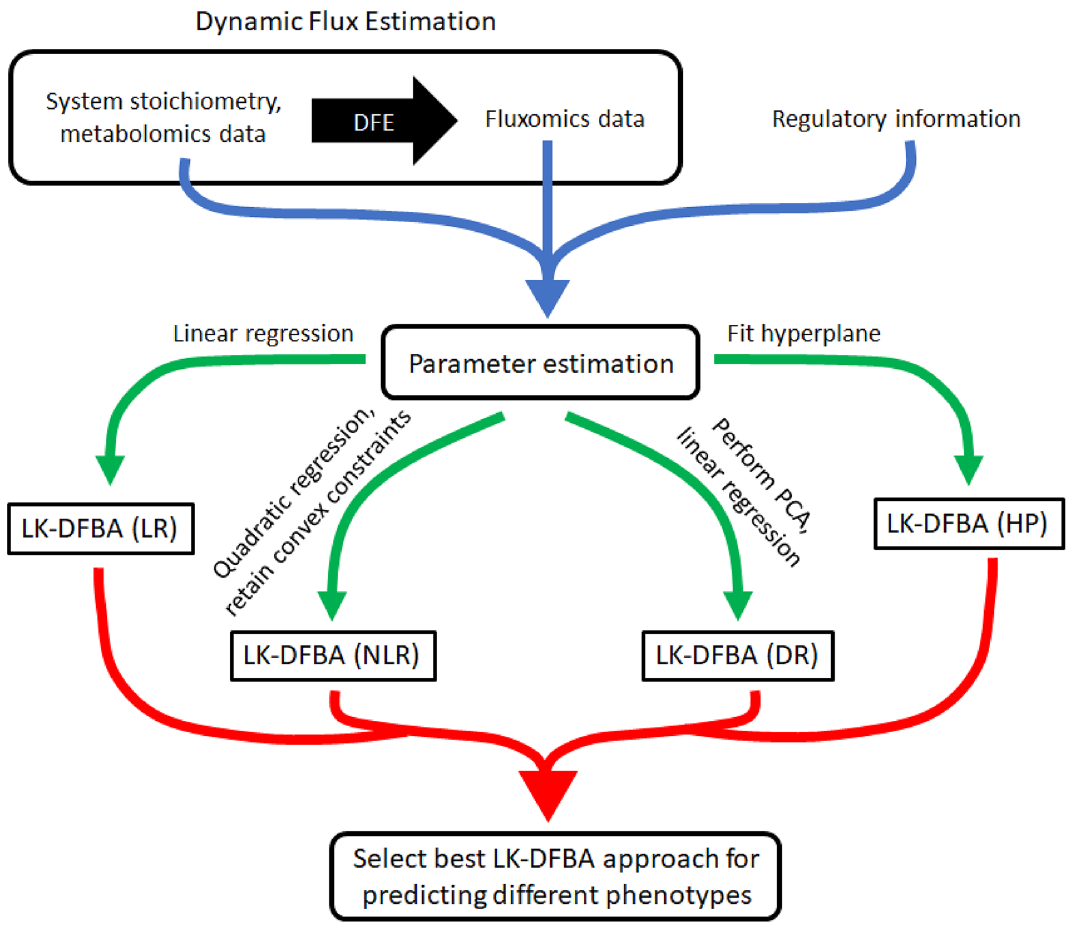
Figure 6. Workflow for selecting the best constraint approach for LK-DFBA when modeling metabolic systems. Dynamic Flux Estimation (DFE) is applied to the system stoichiometry and available metabolomics data to infer instantaneous fluxes. The system stoichiometry, metabolomics data, inferred flux data, and system regulatory information are then used to estimate parameters for each LK-DFBA approach (blue arrow). Using multiple constraint approaches (green arrows), four different LK-DFBA models are created and tested for their respective abilities to recapitulate training data. The model with the lowest error is selected and can be used for future in silico predictions (red